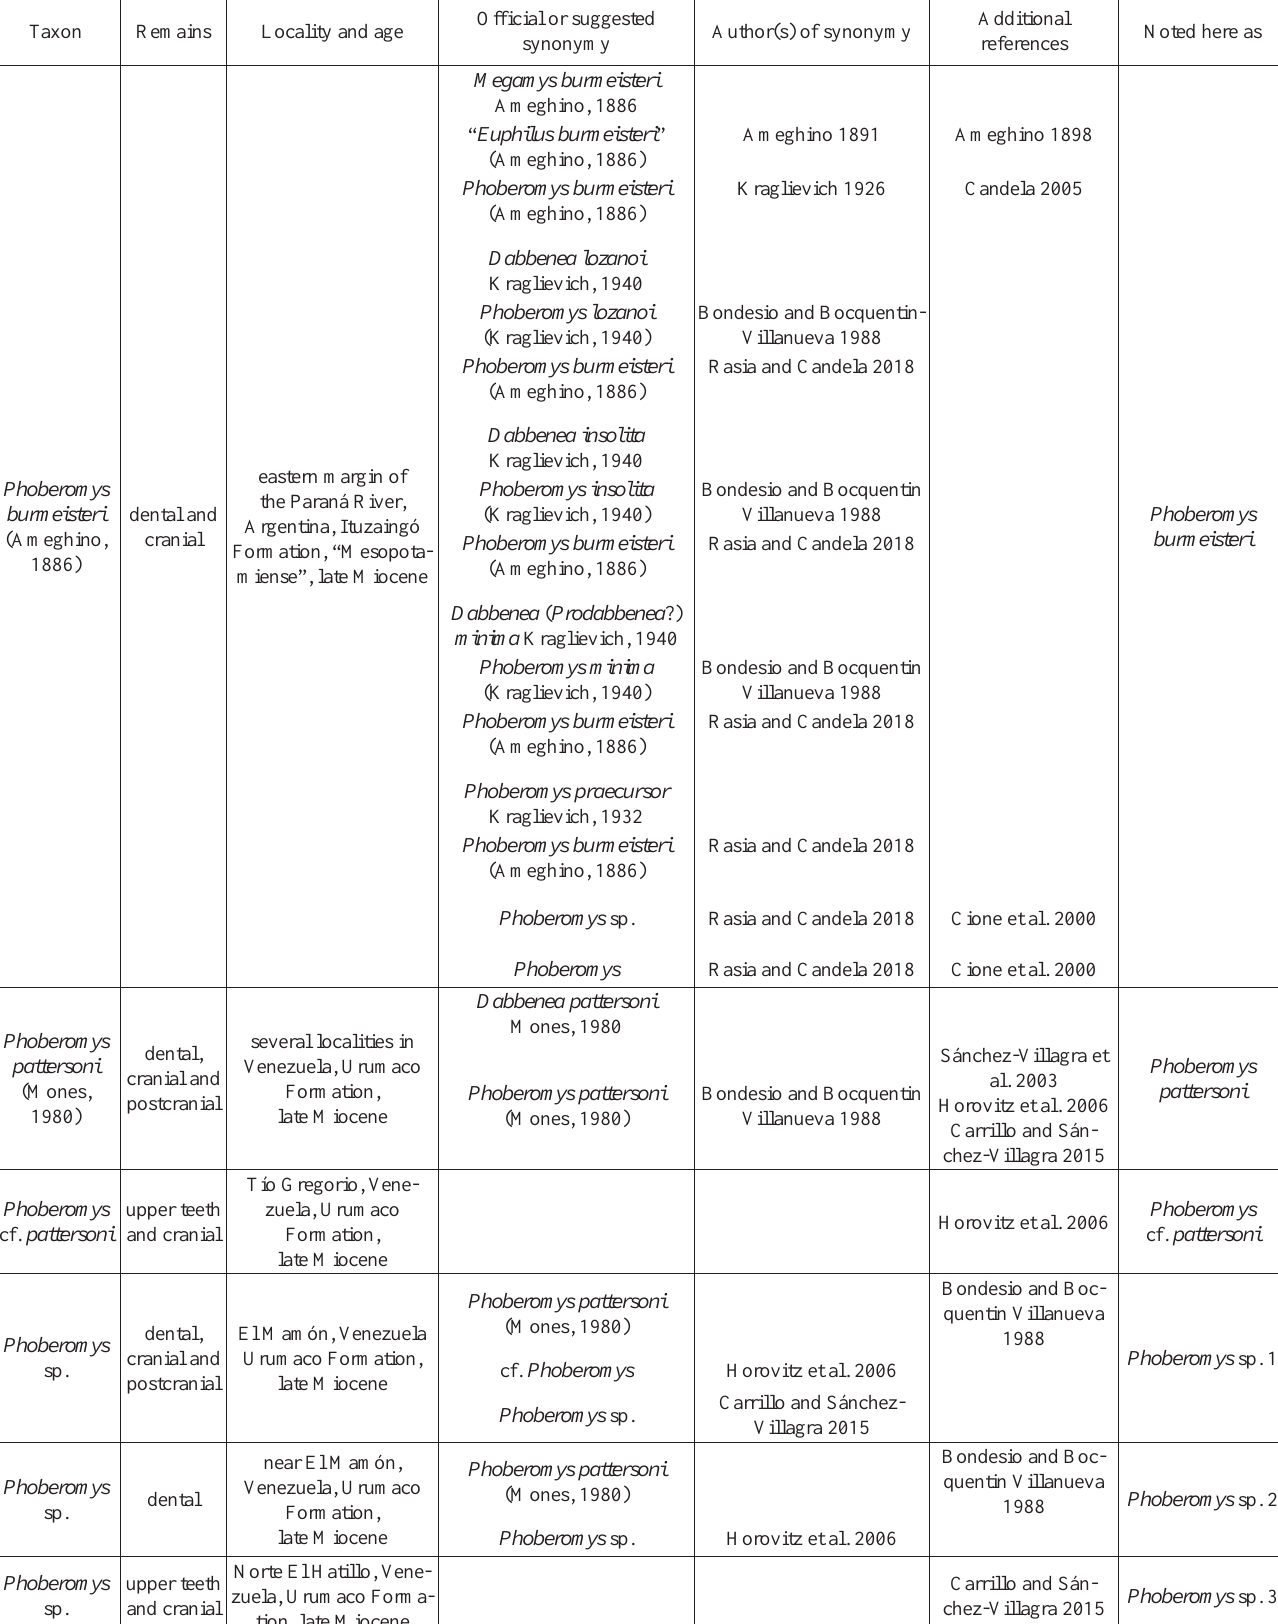
Table 1. Records of the extinct neoepiblemid rodent Phoberomys from the literature and history of their synonymies or suggested synonymies.